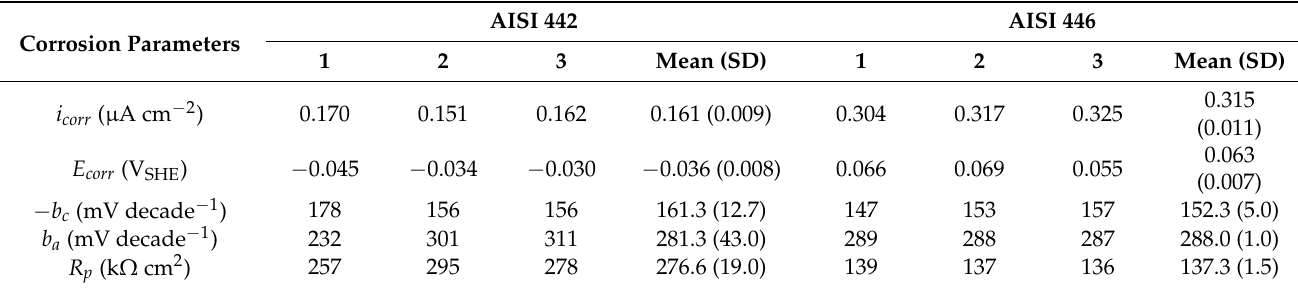
Table 2. Corrosion parameters of AISI 442 and AISI 446 steel samples obtained in 0.1 M Na 2 SO 4 + 0.1 ppm F − (pH = 5).